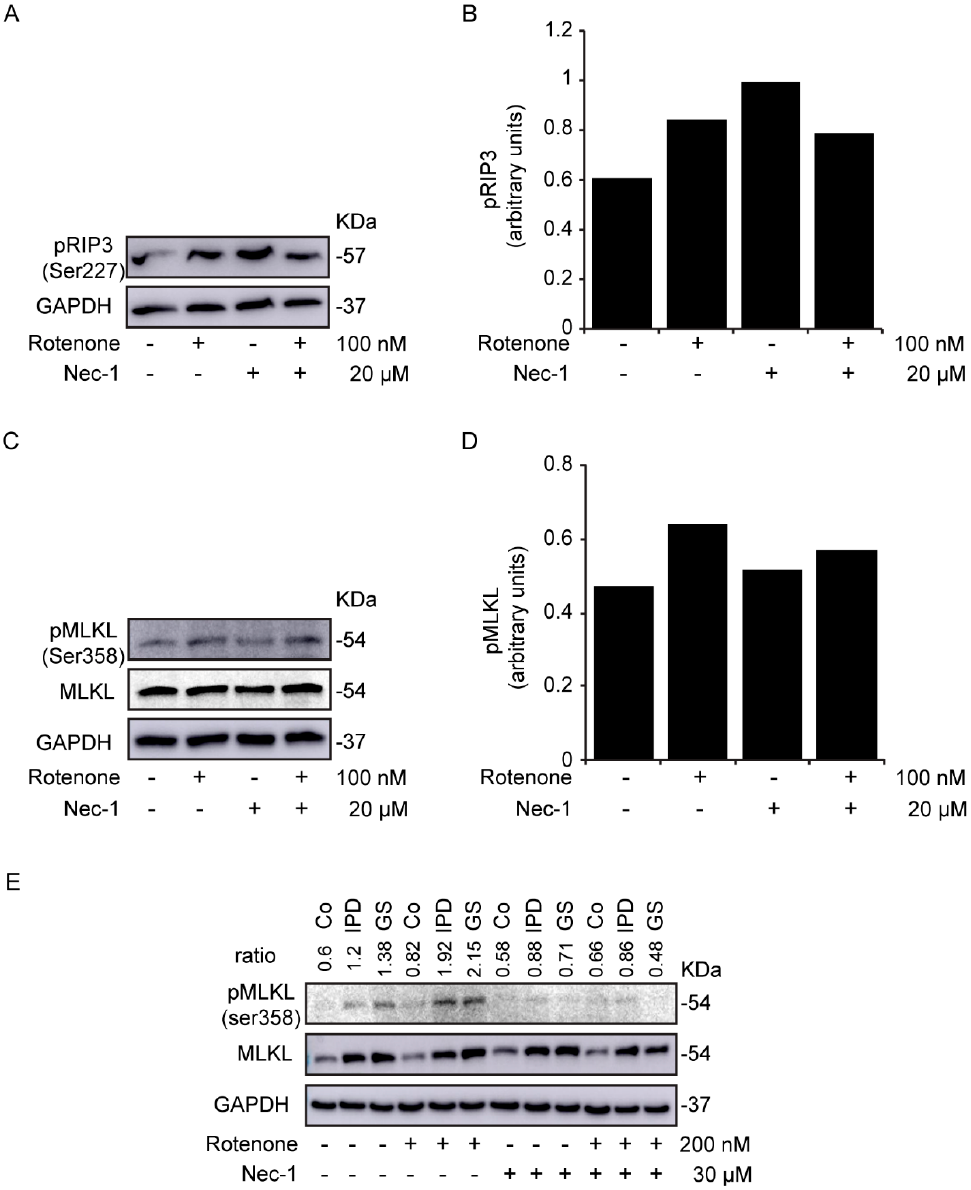
Figure 2. Rotenone-induced necroptosis in SH-SY5Y cells. ( A – E ) Cells were treated with rotenone and / or necrostatin-1 (Nec-1) for 24 h. The expression levels of p-RIP3 ( A , B ) and p-mixed lineage kinase domain-like (MLKL) protein ( C , D ) were determined in SH-SY5Y cells and normalized to the loading control, GAPDH. Data are the values of the representative blot. ( E ) is the representative blot of p-MLKL and MLKL expression levels in human fibroblasts. The ratio is the densitometry of p-MLKL / MLKL. GAPDH was used as the loading control. Experiments were conducted three times.